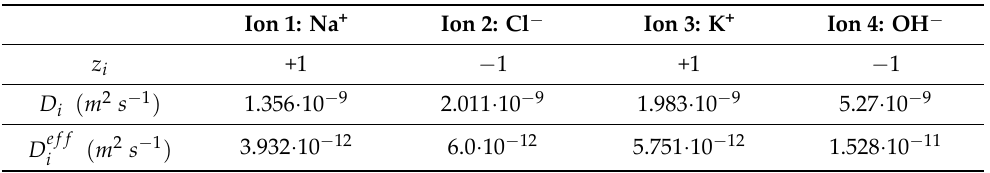
Table 9. Charge numbers, diffusion coefficients of ions in electrolyte D i and ions effective diffusion coefficients D ef f